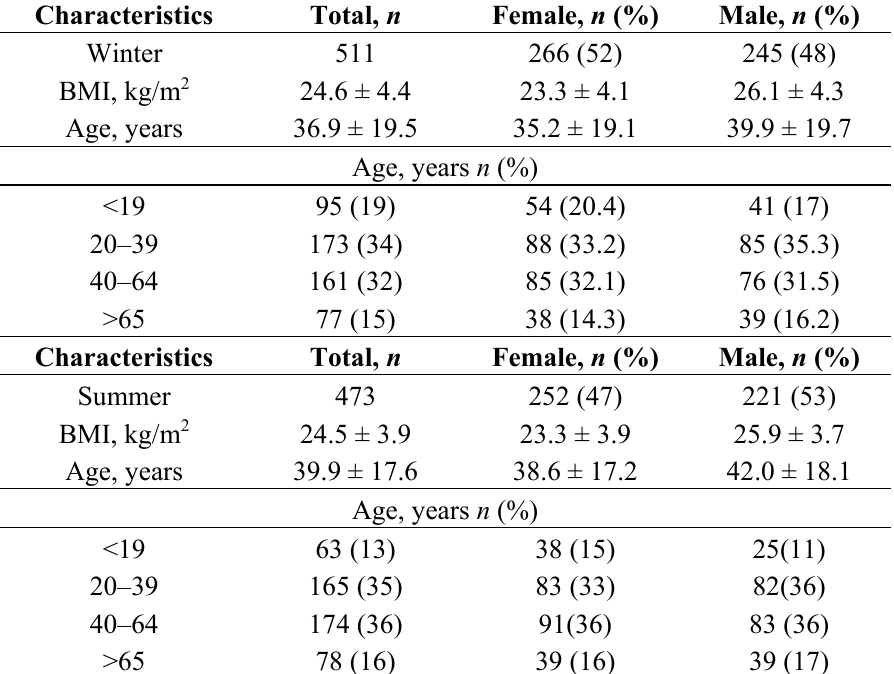
Table 1. Participant’s BMI, age and sex distribution during summer and